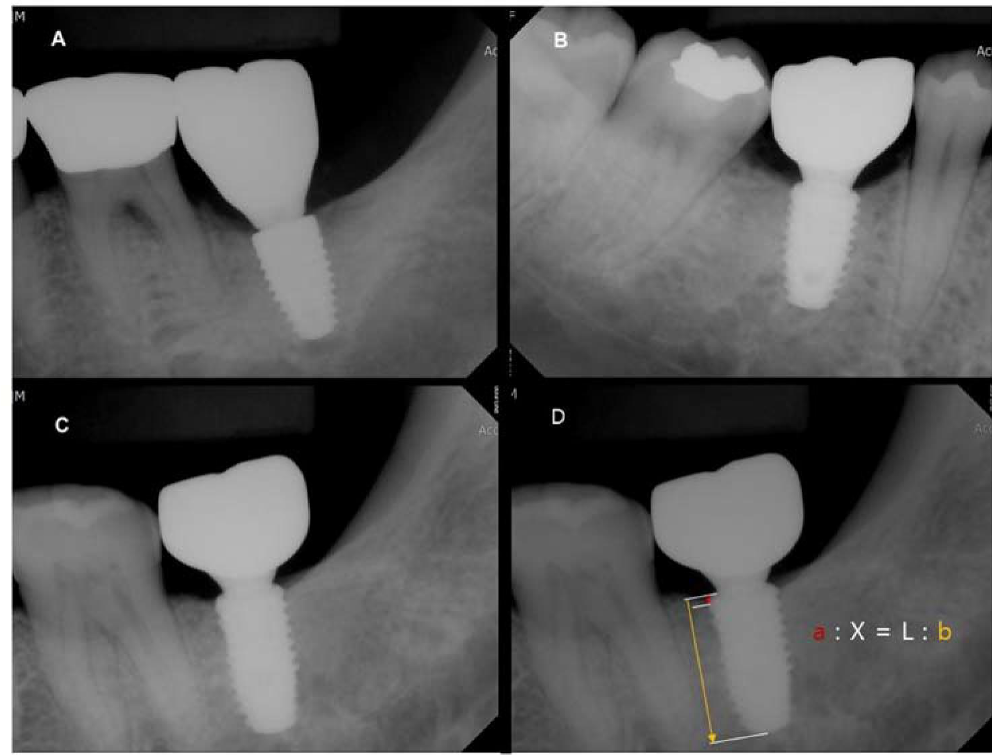
Figure 4. Comparison of marginal bone loss 24 weeks after surgery. ( A ): control group; ( B ): experiment 1; ( C ): experiment 2; ( D ): measurement of marginal bone loss (MBL) on periapical radiograph (X: distance between platform and peri-implant bone crest).